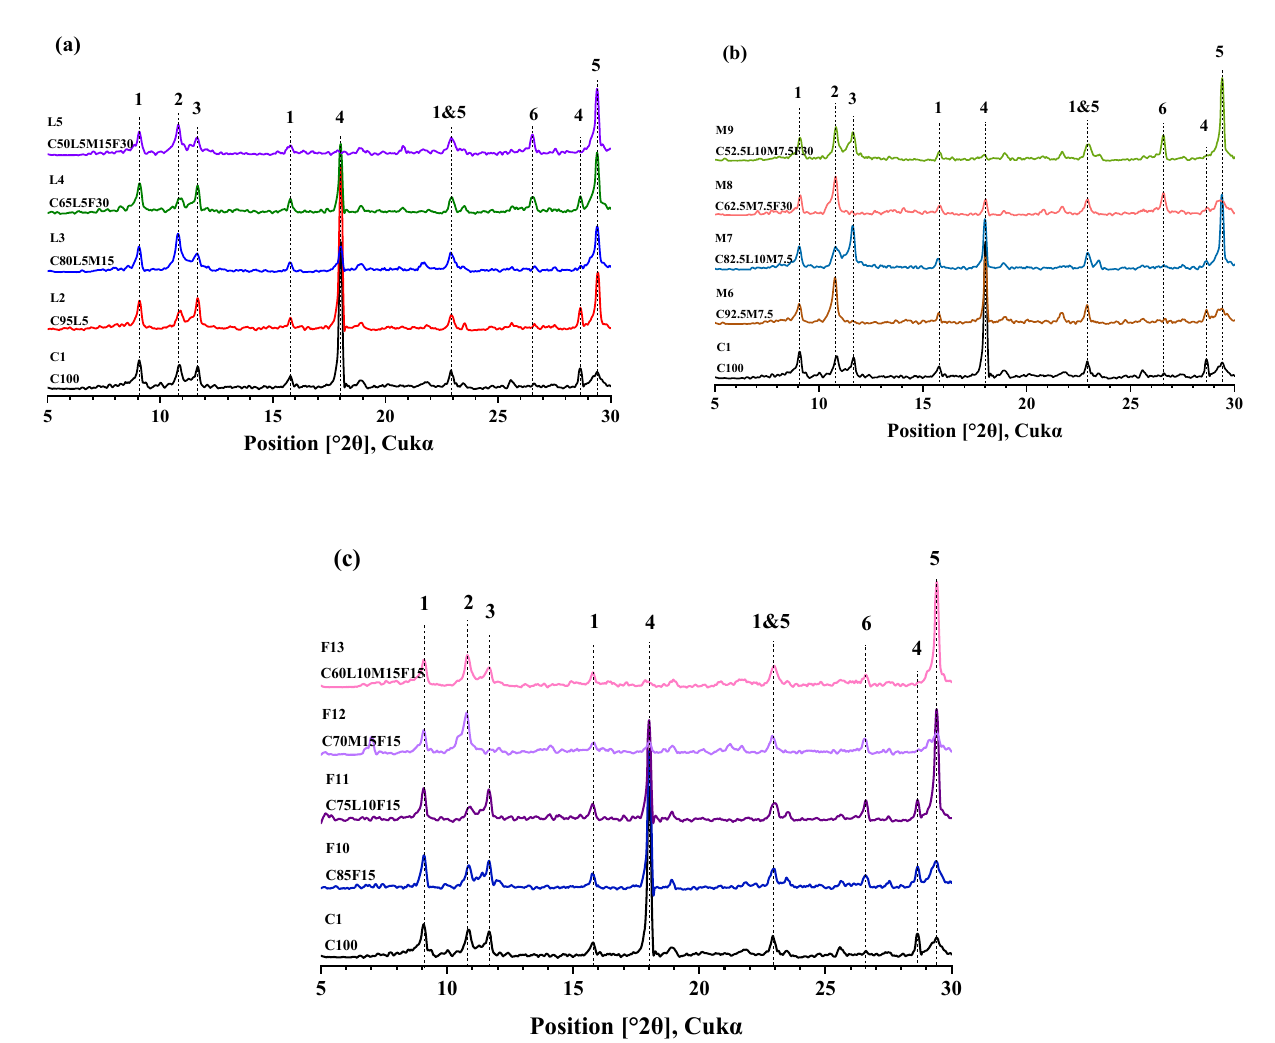
Figure 9. XRD analysis: ( a ) the control specimen and LS system, ( b ) the control specimen and MK system, and ( c ) the control specimen and FA system (1 = ettringite; 2 = hemicarboaluminate; 3 = monocarboaluminate; 4 = portlandite; 5 = calcium carbonate; 6 = quartz).